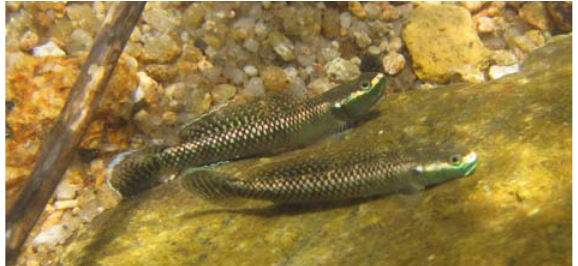
Image 3. Stiphodon atropurpureus (male) Image 4. Stiphodon atropurpureus (male) during courtship